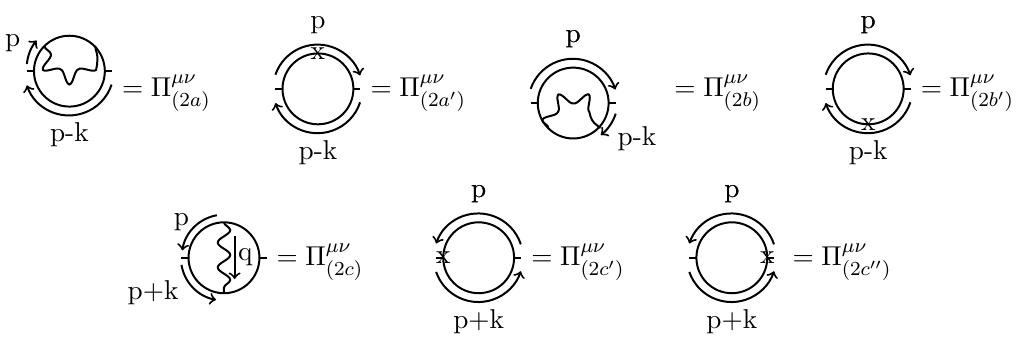
Figure 4 . Two-loop diagrams for the photon two-point function coming from the action (1.1) and one-loop counterterms associated with it (represented by an